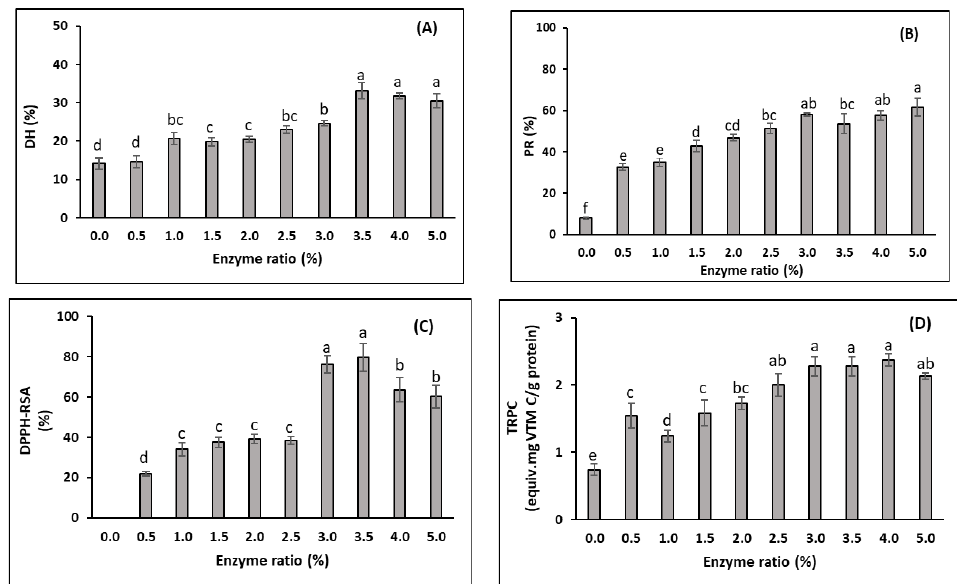
Figure 2. Effects of the enzyme/substrate ratios on properties of FPHs obtained from DM-FPI (trial 1), including: ( A ) degree of hydrolysis (DH, %); ( B ) protein recovery (PR, %); ( C ) DPPH radical scavenging activity (DPPH-RSA, %); and ( D ) total reducing power capacity (TRPC, equiv. mg vitamin C/g FPH protein). The hydrolysis reaction was carried out at 50 °C for 3 h. Different lowercase letters show significant differences at a significance level of p <